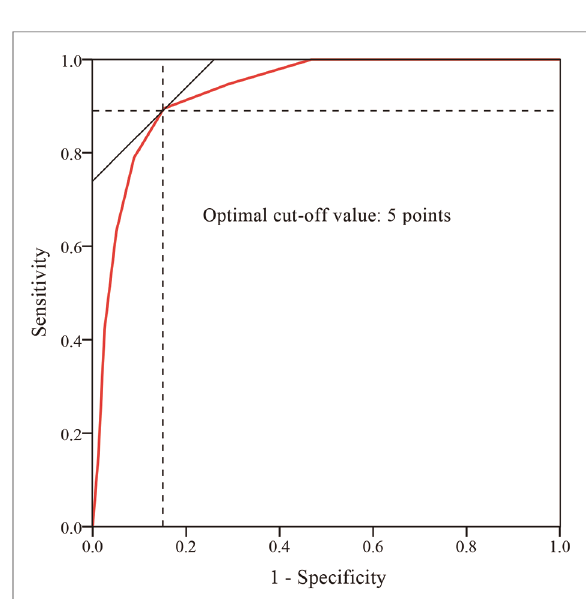
FIGURE 3 ROC curve analysis of the scoring system. The optimal cut-off point based on the ROC curve analysis of scores was 5